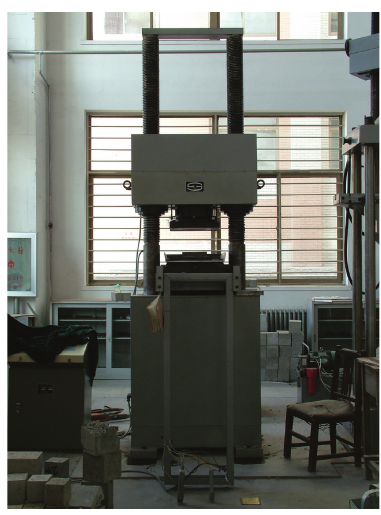
Figure 2: Compression testing machine.